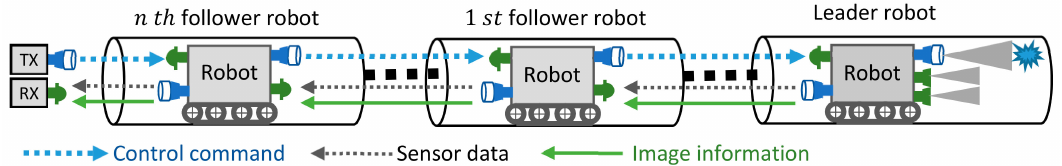
Figure 12. The whole architecture of the